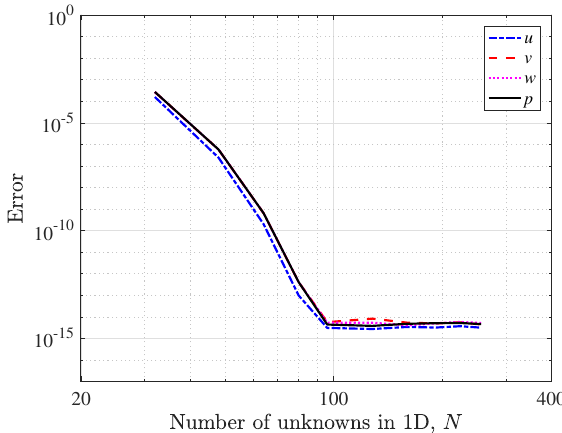
Figure 6. Numerial errors of u , v , w , and p as a function of N in solving the Stokes problem.